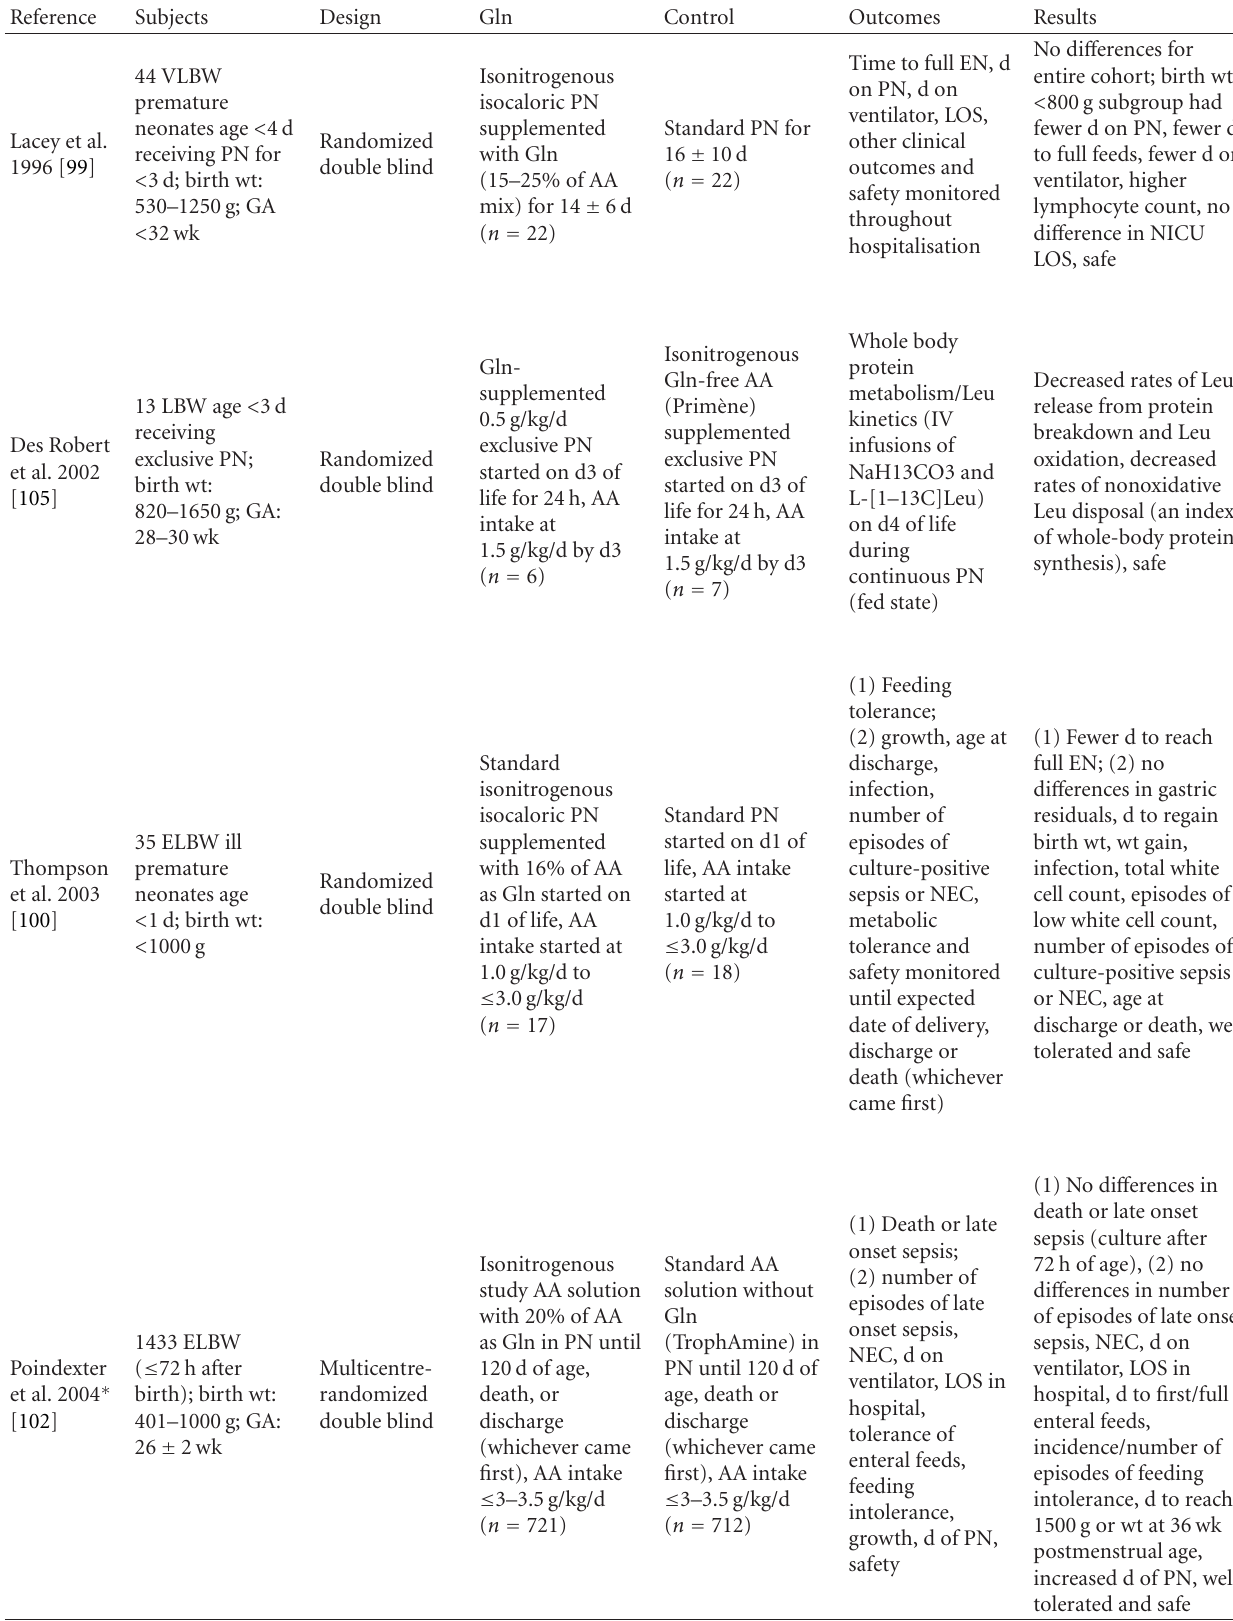
Table 1: Glutamine-supplemented parenteral nutrition in premature